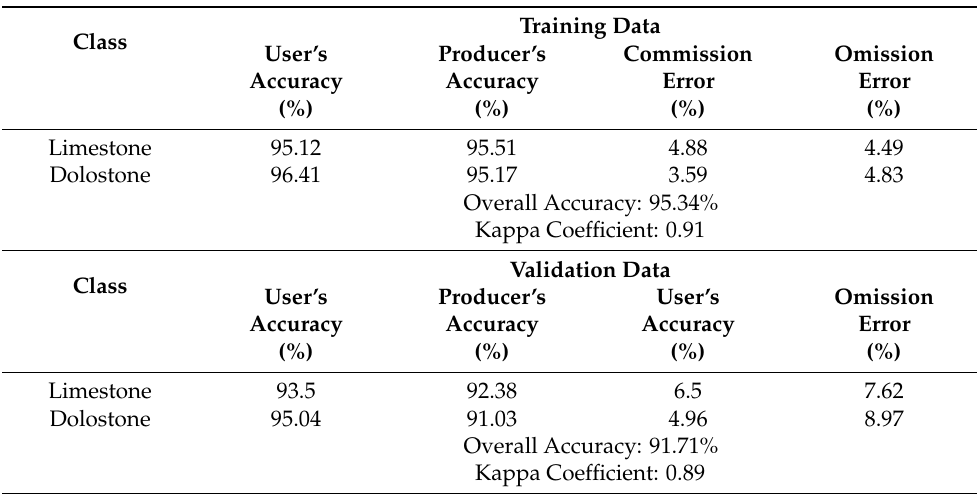
Table 2. Confusion matrix table of the training and validation data for the classification results from the RF algorithm.